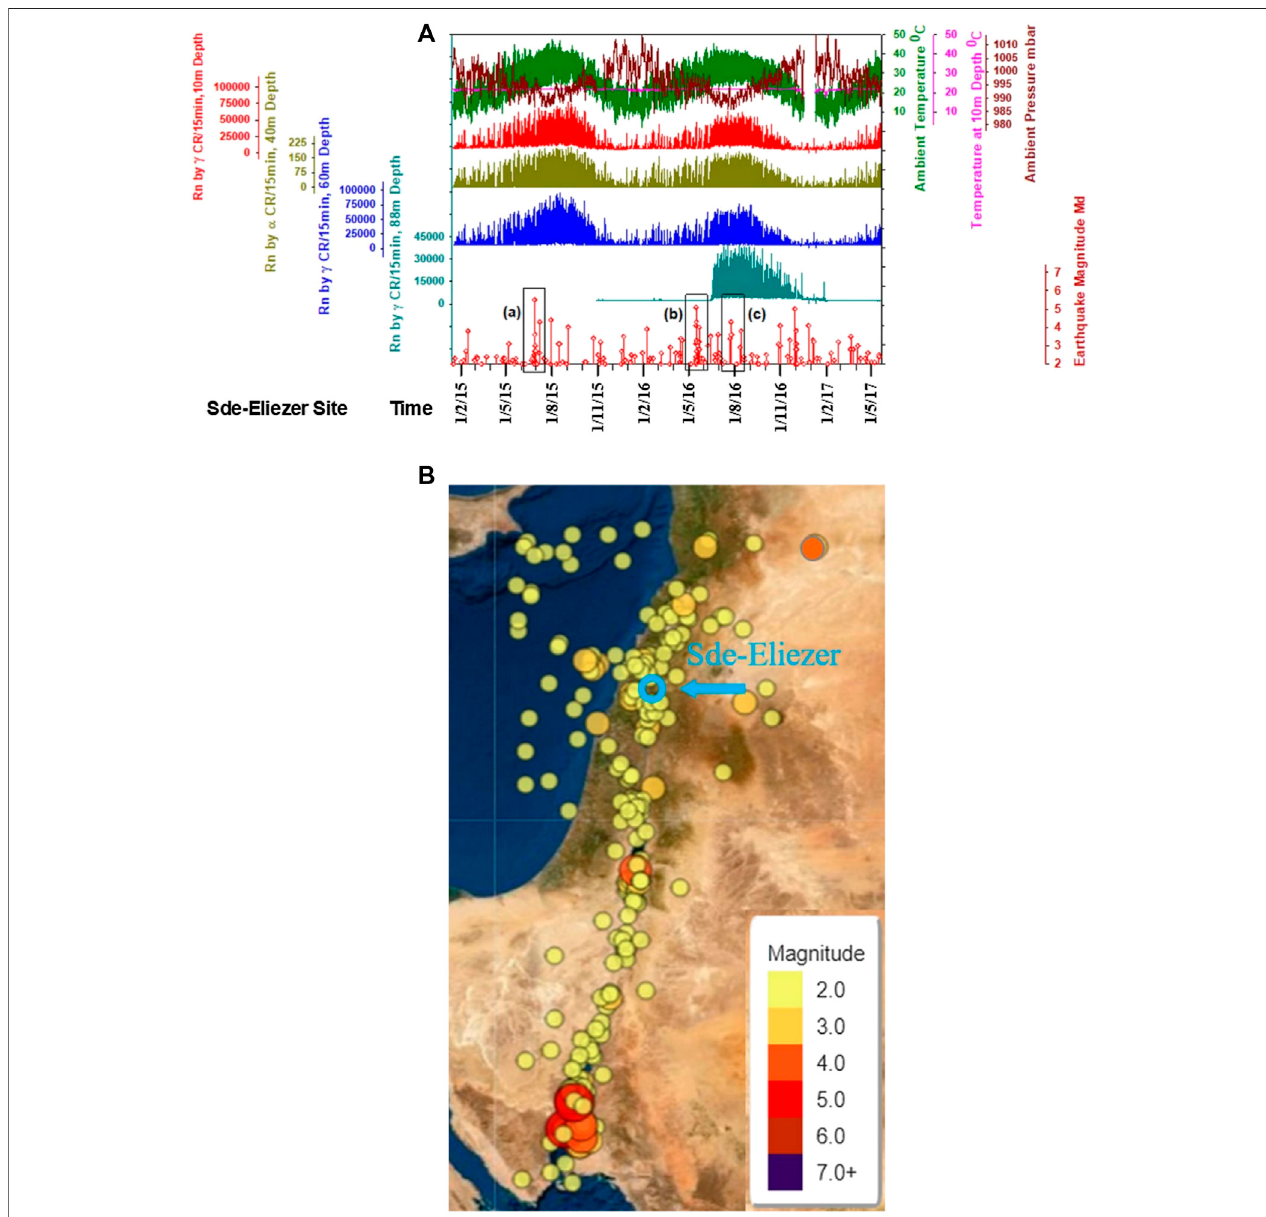
FIGURE 11 | (A) Continuous time series of the measured parameters at the Sde-Eliezer site (with 15-min temporal resolution) collected during the fi rst two and a half years (844 days). The parameters measured including: barometric pressure ( dark red ), ambient temperature ( green ), borehole temperature at 10 m depth ( pink ), radonwithinthesurroundingrocks at 10 m depth asmeasuredbygammarays (red ),radonwithintheboreholeairspaceat 40 mdepth asmeasuredbyalphaparticles ( dark yellow ), radon within the surrounding rock at 60 m depth as measured by gamma rays ( blue ), radon within the groundwater at 88 m depth (since November2015, cyan ). (B) Morethan260earthquakeswithmagnitudegreaterthanM (cid:1) 2)recordedbytheIsraelSeismicNetworkofTheGeophysicalInstituteofIsrael [http://seis.gii.co.il]. For three time periods marked in letters a , b , c , there were three earthquakes preceded by an unusual radon anomalous signal.